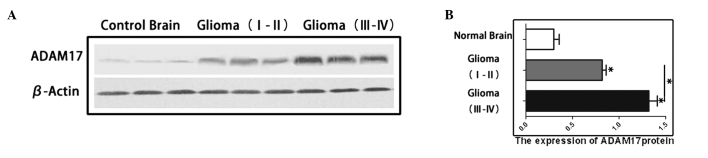
ADAM17 protein expression significantly increases with ascending glioma grade. (A) Expression of ADAM17 protein level in different grades of glioma. (B) Graphical representation of the ADAM17 protein level expression profiles. Data are presented as the mean ± standard error, *P<0.05, III–IV vs. I–II, III–IV vs. normal, and I–II vs. normal. ADAM17, a disintegrin and metalloproteinase-17.